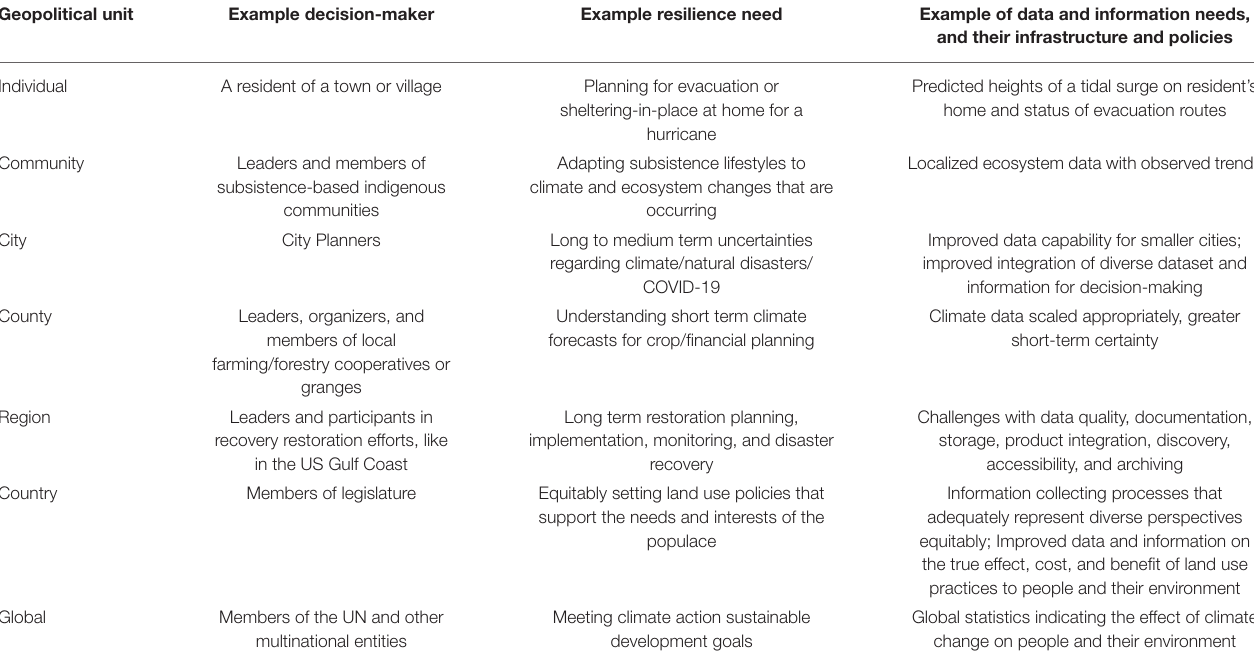
TABLE 1 | How geopolitical scale matters for community resilience data/information